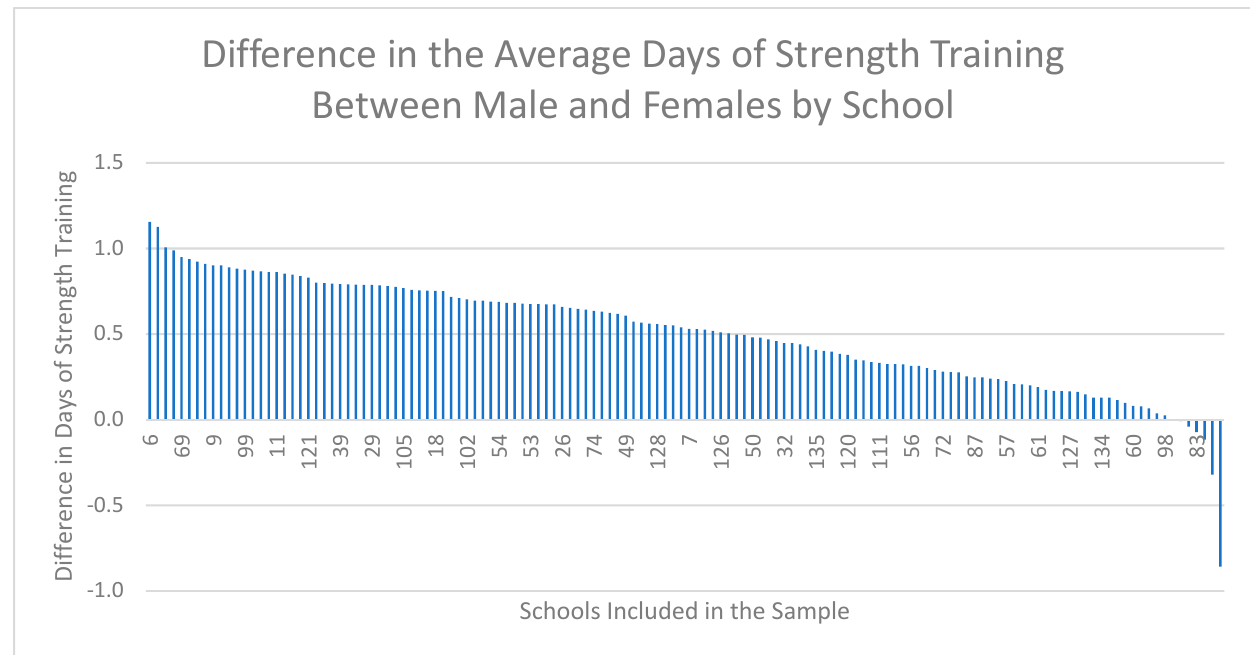
Figure 2. School-level differences ( n = 136) between the average days of strength training per week for male and female students from Year 7 (2018–2019) of the COMPASS study. Note: The difference is calculated as the average weekly strength training days for males minus the average weekly strength training days for females.